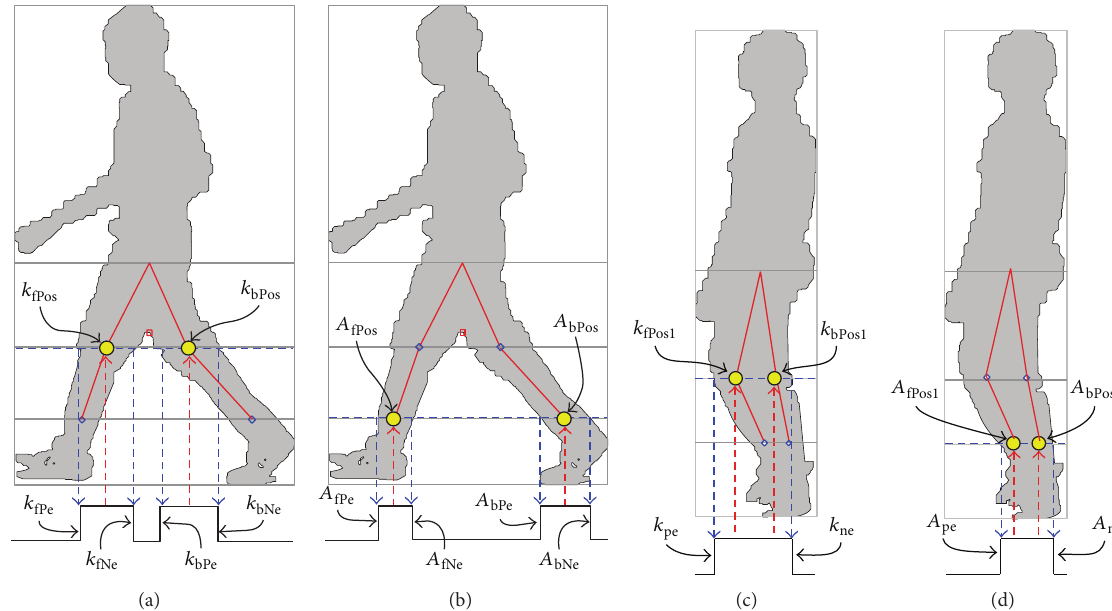
Figure 7: (a) Knee positions on normal silhouette. (b) Ankle positions on normal silhouette. (c) Knee positions on self-occluded silhouette. (d) Ankle positions on self-occluded silhouette.